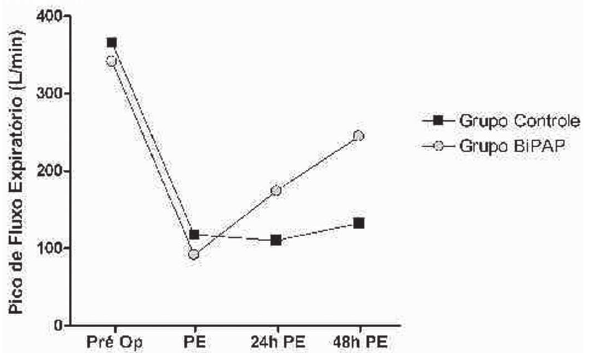
Fig. 2 – Distribuição representativa das alterações do Pico de Fluxo Expiratório no pré-operatório, pós-extubação imediata, 24 e 48 horas pós-extubação em média, nos grupos Controle e BiPAP. Pré-op= Pré-operatório e PE= Pós-extubação. (P<0,001 intragrupos; P=0,327 intergrupos)